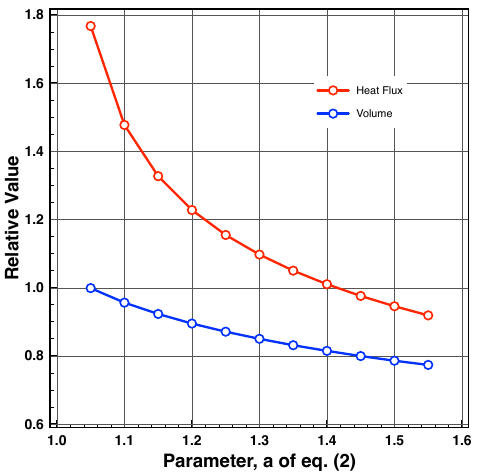
Figure 12. Effect of parameter of hyperbolic contours on the relative value of the volume and the stagnation point heat flux of the